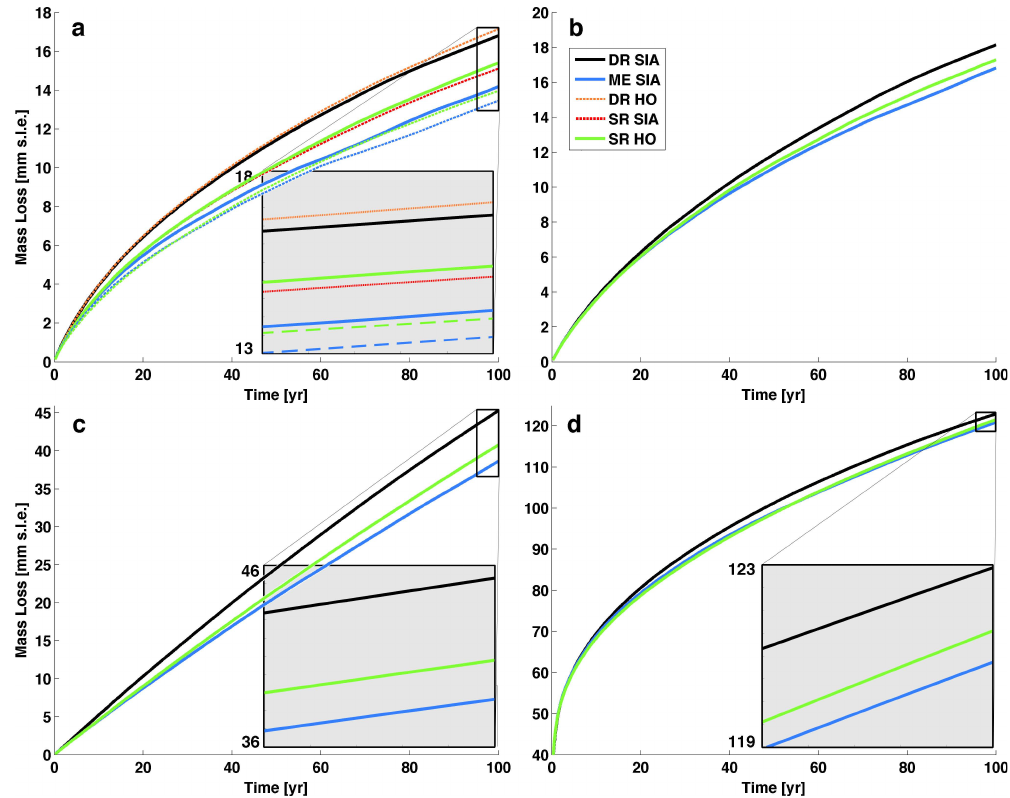
Fig. 2. Ice mass loss of different model versions on 5km resolution for the three forcing scenarios: (a) MarAsl2, (c) TotAsl2, (d) MarCut started from IS while in panel (b) MarAsl2 is initiated from PS. Mass loss is determined by subtracting the background signal from a control experiment. The mass loss differs by no more than 20% amongst the model versions and results are robust under different initial conditions (a) and (b) . Each close-up zooms in on the last 5yr of the experiments. The dashed blue (ME SIA) and green (SR HO) line represent the respective model version using a full nonlinear sliding law (cf. Appendix